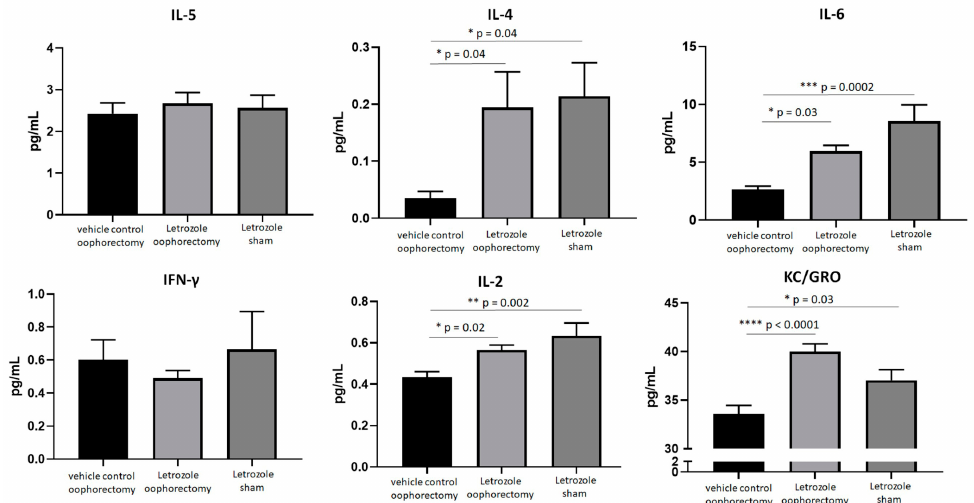
Figure 7. Aromatase inhibitors induce pro-inflammatory cytokine levels in the serum of NF κ B-RE-luc mice independent of physiological estrogen depletion. Female NF κ B-RE-luc mice underwent oophorectomy or control (sham) surgery and were treated with the aromatase inhibitor letrozole for comparison to negative (vehicle) controls. Cytokine levels from serum were measured via electrochemiluminescence detection using a pro-inflammatory panel. Values are the mean ± SEM, with indicated p values calculated from one-way ANOVA with Tukey’s corrections for multiple comparisons. * p ≤ 0.05; ** p ≤ 0.01; *** p ≤ 0.001; **** p ≤ 0.0001. All values of p ≤ 0.05 were considered